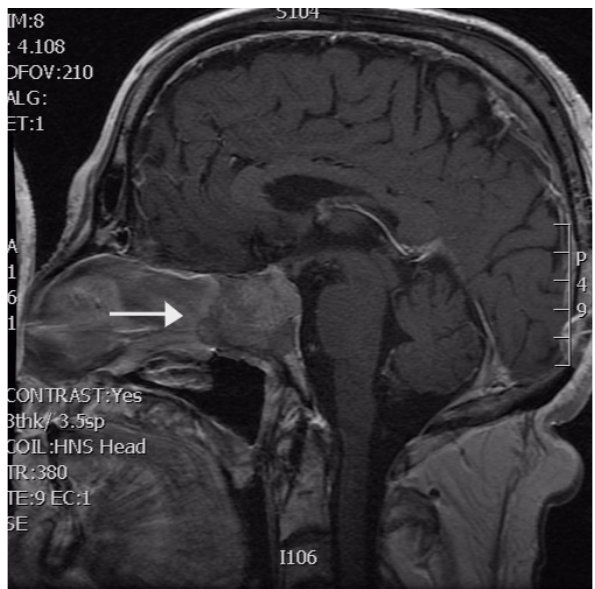
Fig. 1. Contrast-enhanced brain MRI, T1-weighted sagittal scans. Intrasellar and intrasphenoid tumour, indicated by an arrow.